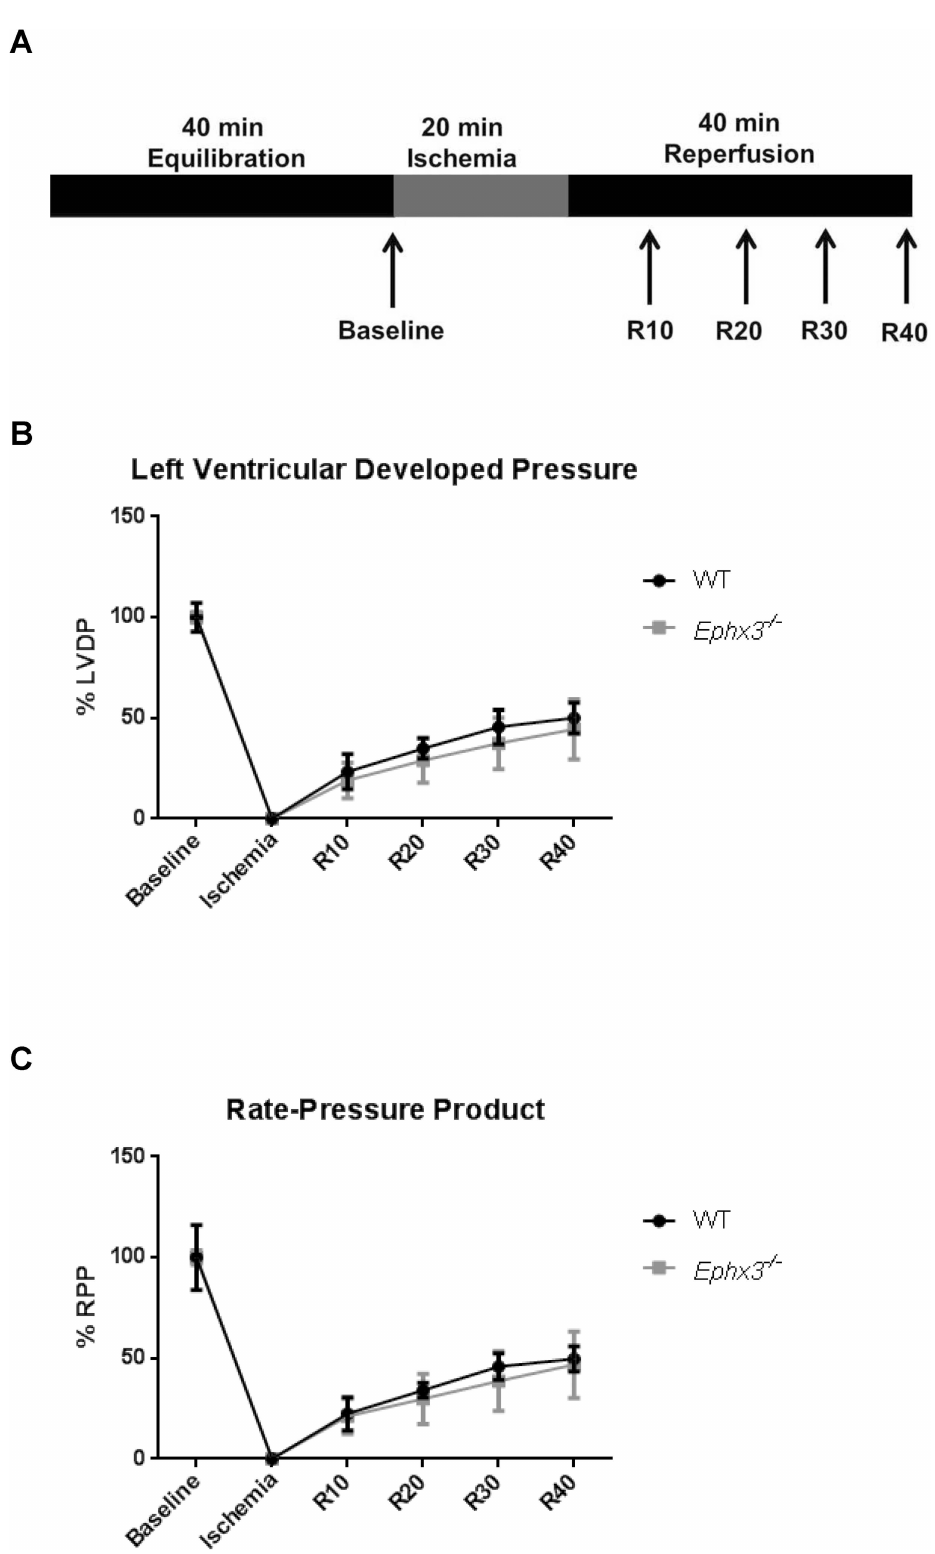
Fig 9. Cardiac recoveryis unchanged in Ephx3 -/- hearts after global ischemia/reperfusion. (A) Hearts were allowedto equilibratefor 40 min, subjectedto 20 min of global, no-flowischemia, and then reperfused for